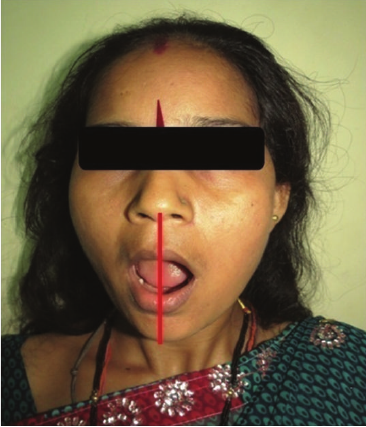
Figure 5: Showing deviation of mandible towards right